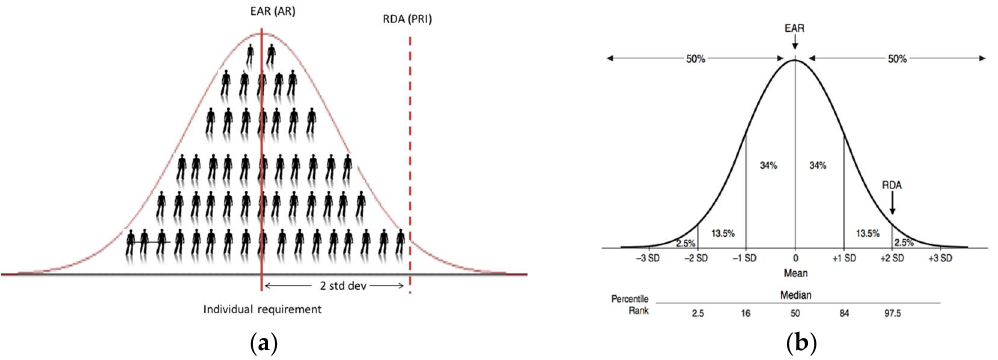
Figure 1. ( a ) The placement of (Estimated) Average Requirement [EAR(AR)] and